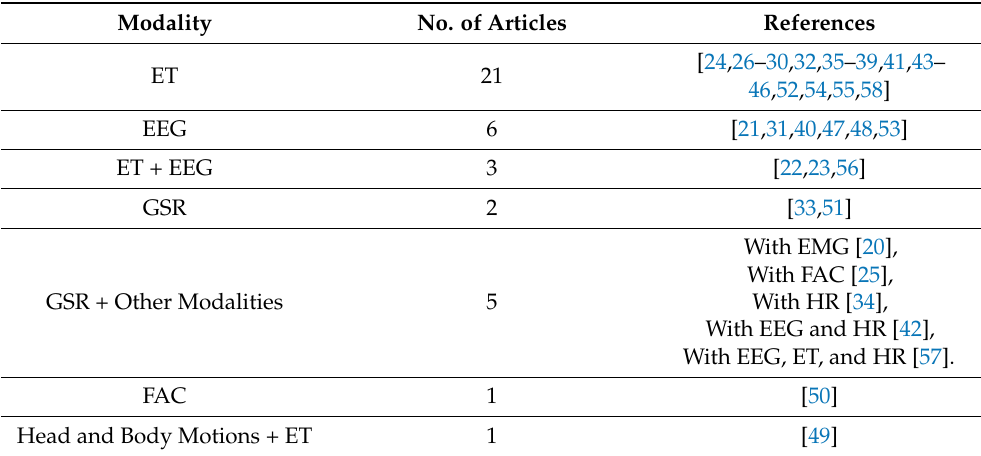
Table 2. Neuro-tourism modalities; eye-tracking (ET), electroencephalography (EEG), galvanic skin response (GSR), facial-action-coding (FAC), heart rate